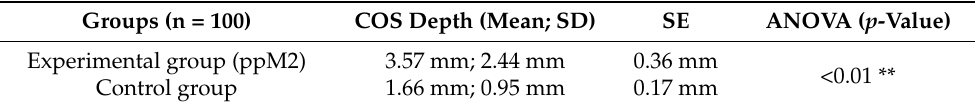
Table 2. COS depth experimental versus control group.